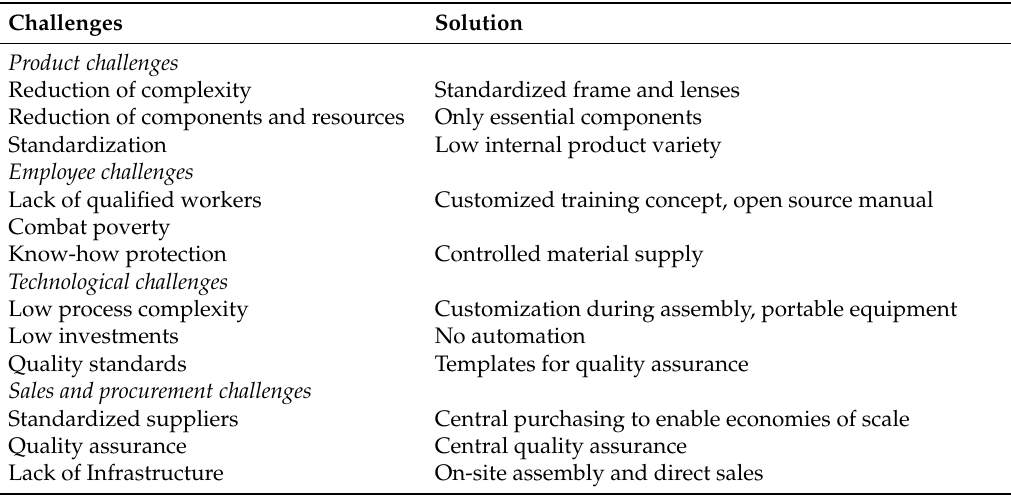
Table 2. Challenges and solutions: OneDollarGlasses